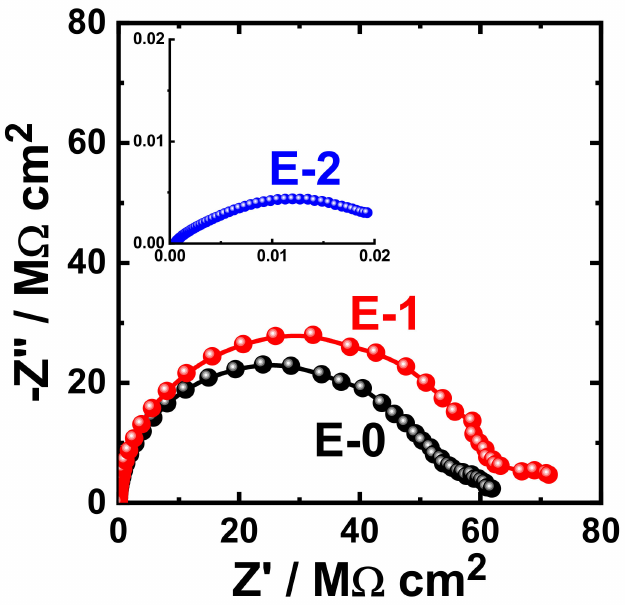
Figure 11. Typical Nyquist plots obtained for E-0, E-1, and E-2 after their immersion in 3.5% NaCl solutions for 14